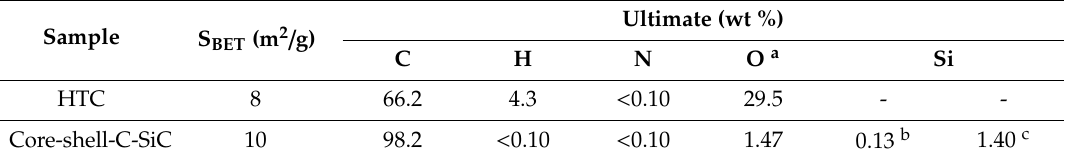
Table 1. Brunauer, Emmett and Teller (BET) surface area, bulk element composition of the hydrochar prepared from glucose (HTC), and the core-shell C-SiC composite.